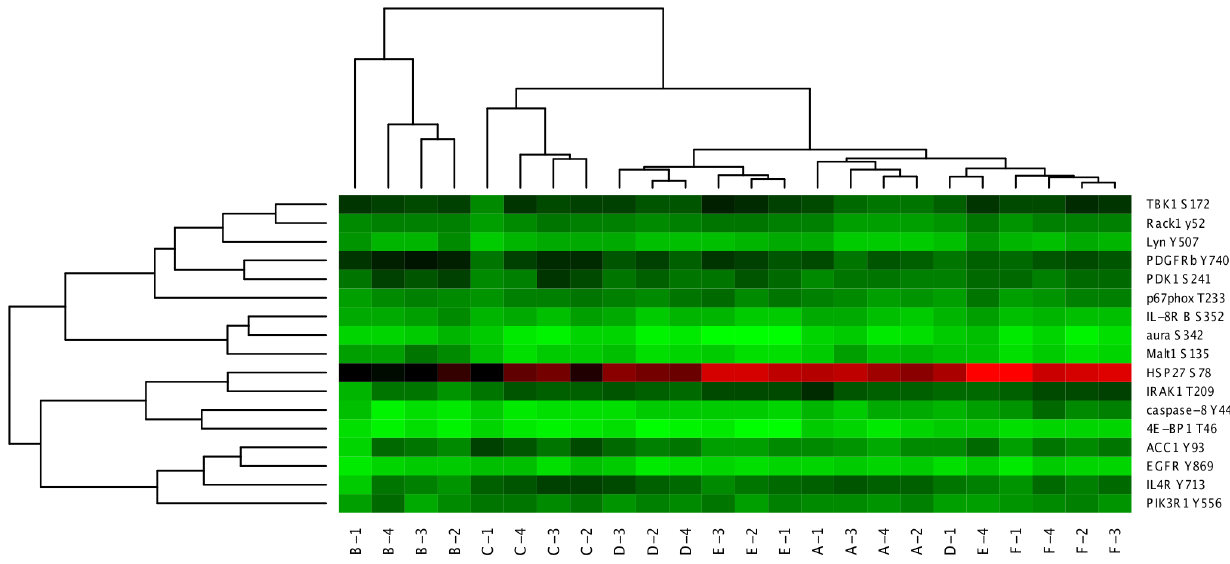
Figure 4. Heatmap and hierarchical clustering of kinome microarray profiles of samples from the example experiment using 17 peptides chosen according to a local search algorithm. The same distance metric and linkage method were used as in Figure 1. The sample names are the same as in Figure 1; the peptide names are also indicated on the right side of each row.